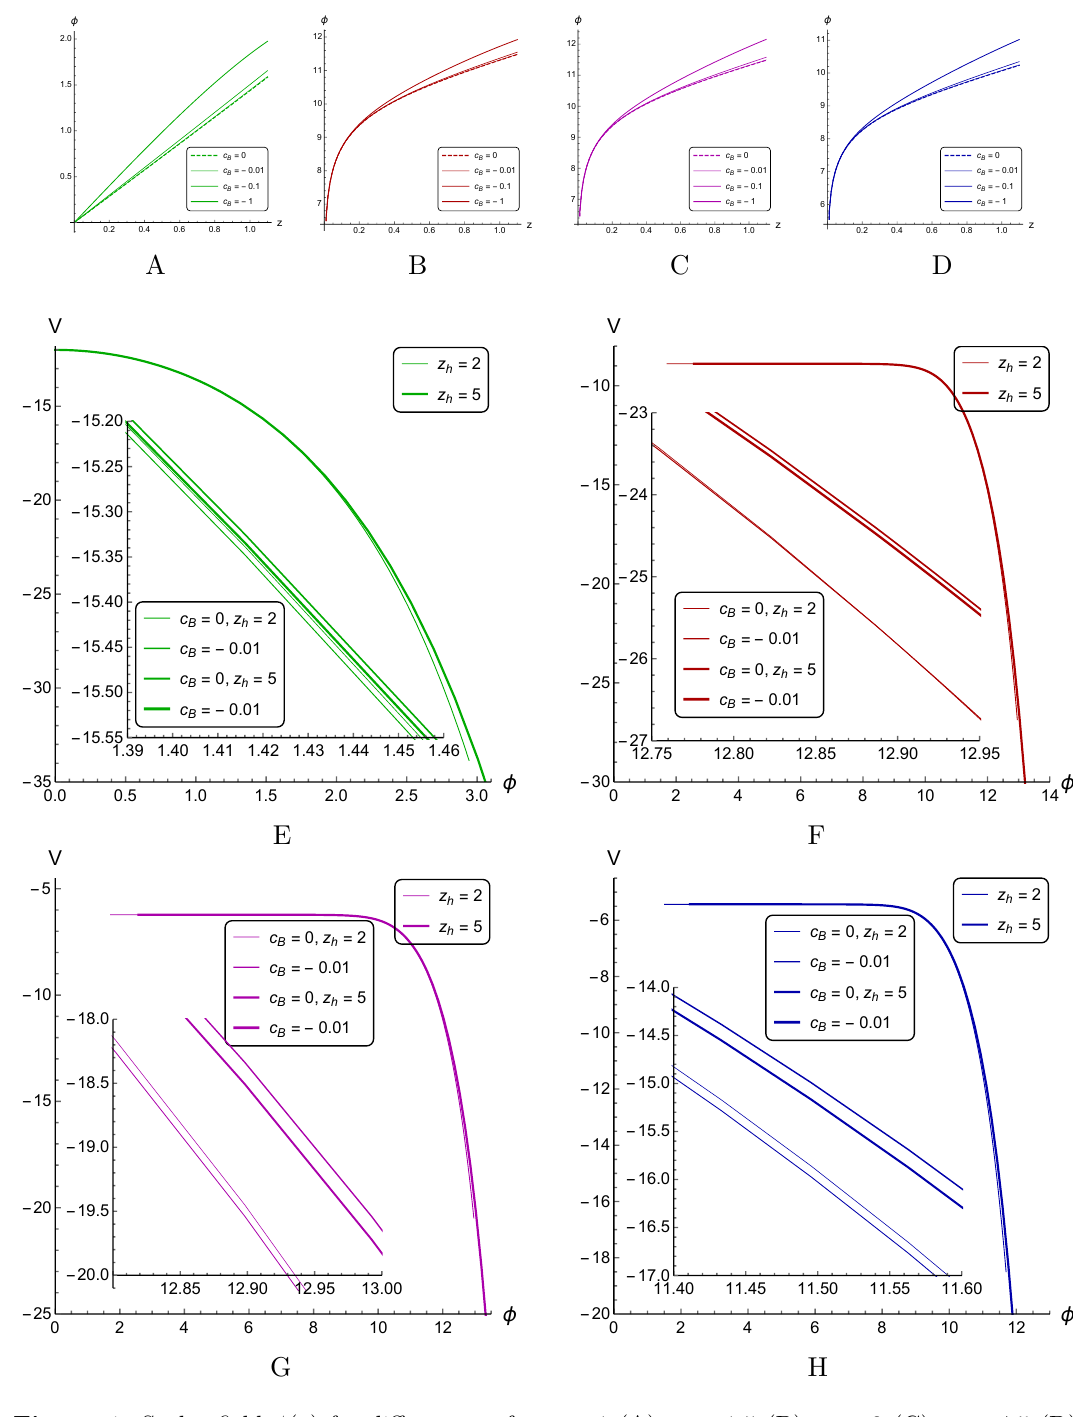
Figure 4 . Scalar field φ ( z ) for different c B for ν = 1 (A), ν = 1 . 5 (B), ν = 3 (C), ν = 4 . 5 (D); scalar potential V ( φ ) for different c B and z h for ν = 1 (E), ν = 1 . 5 (F), ν = 3 (G), ν = 4 . 5 (H) µ = 0 . 1 , c = 0 . 227